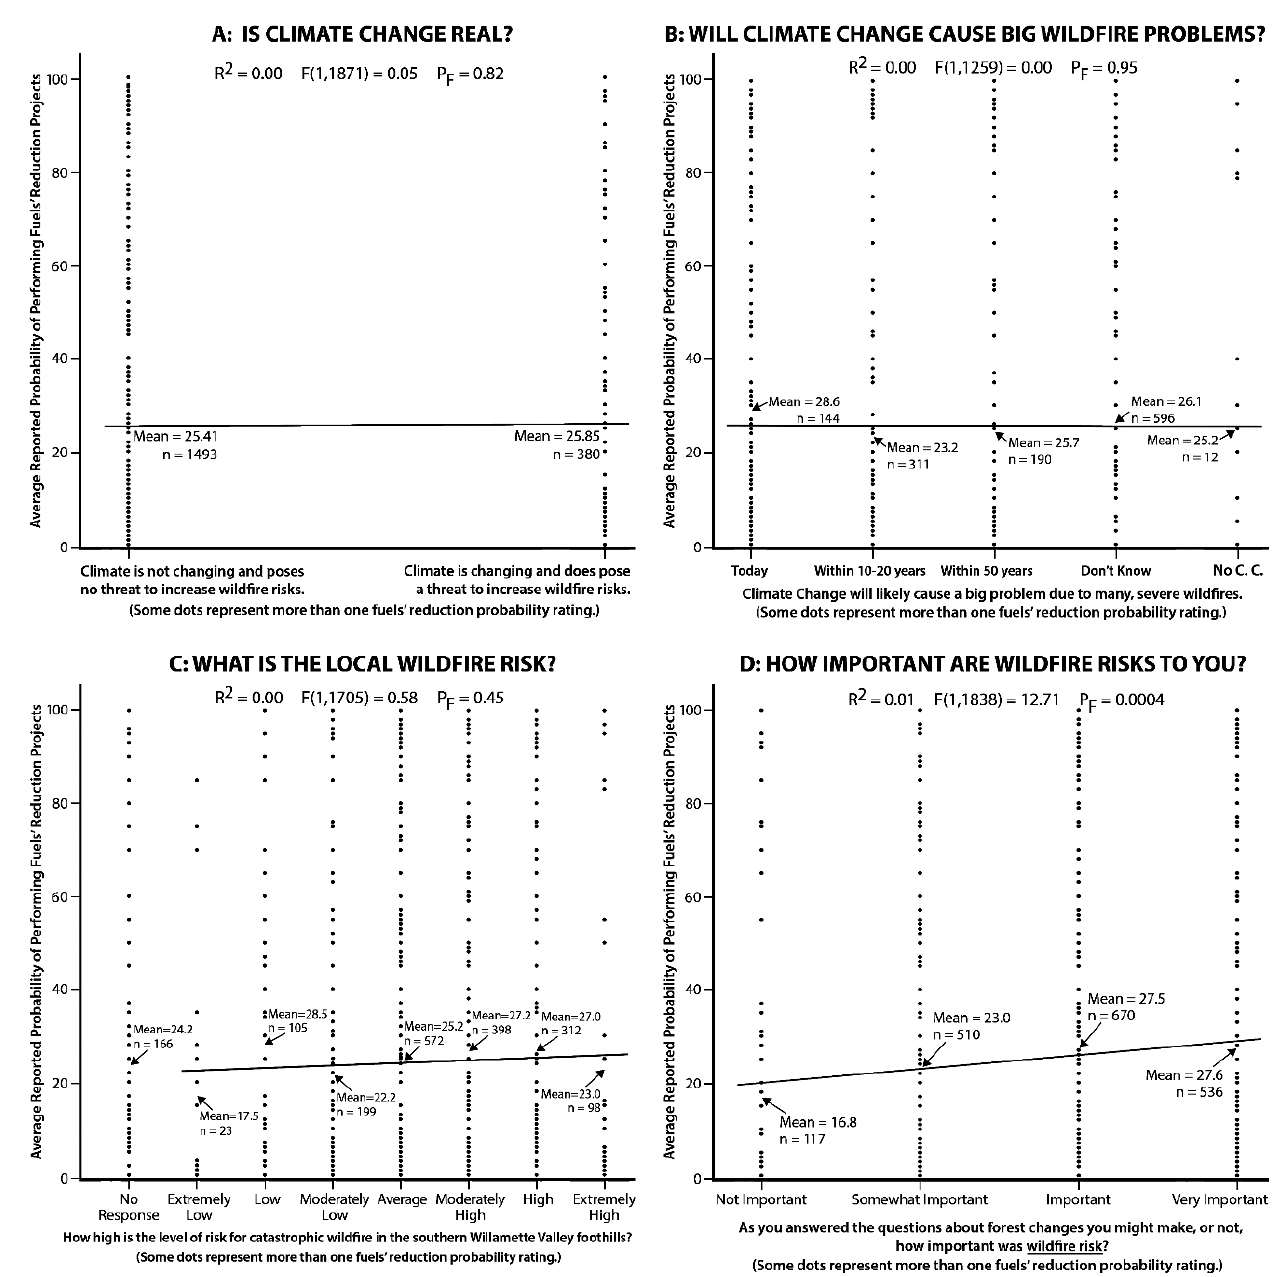
Figure 10. Respondents’ dispositions related to climate change and wildfire risks.